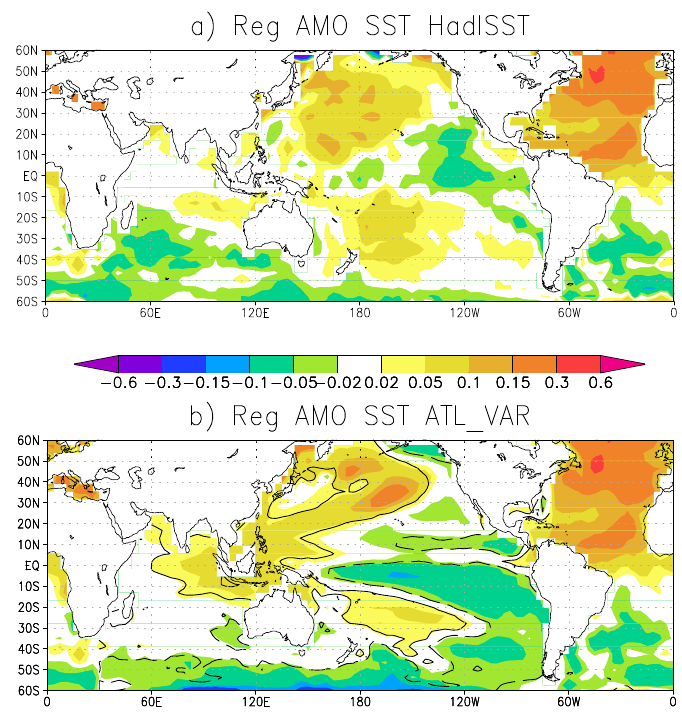
Figure 10. Regression of ( a ) observed and ( b ) ATL_VAR SSTs onto the AMO index. In ( b ), anomalies that are 95% statistically significant are indicated by contours. Units are K.